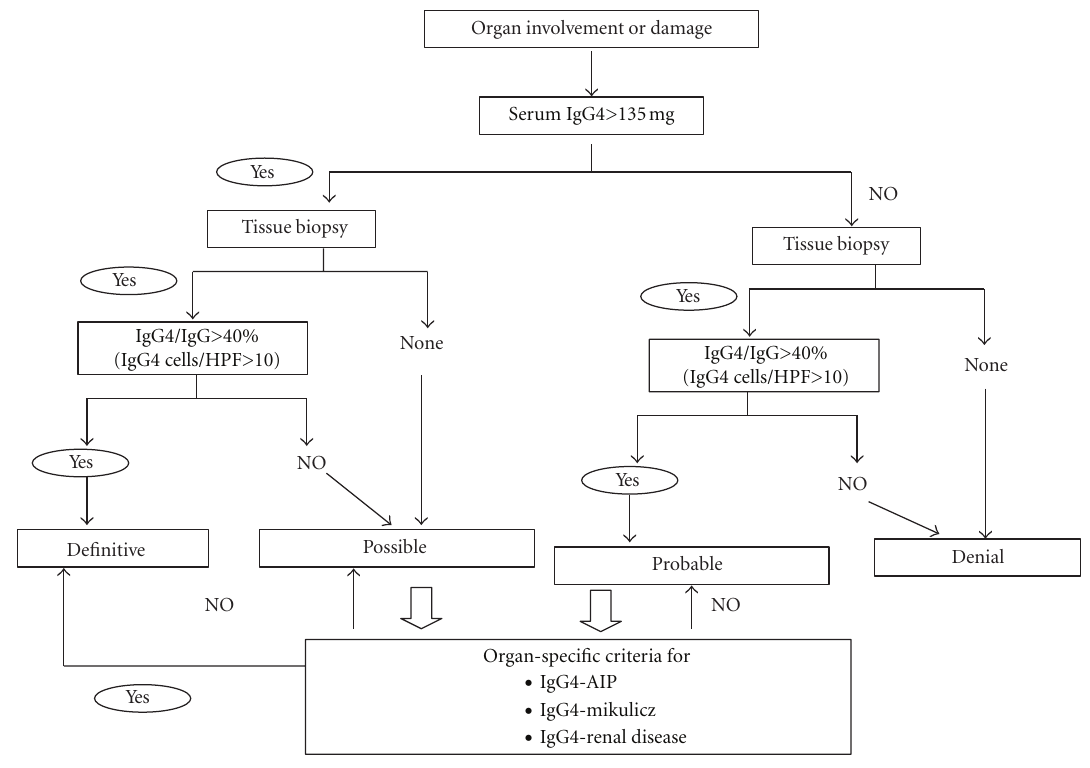
Figure 2: Diagnostic algorithm for IgG4-RD in